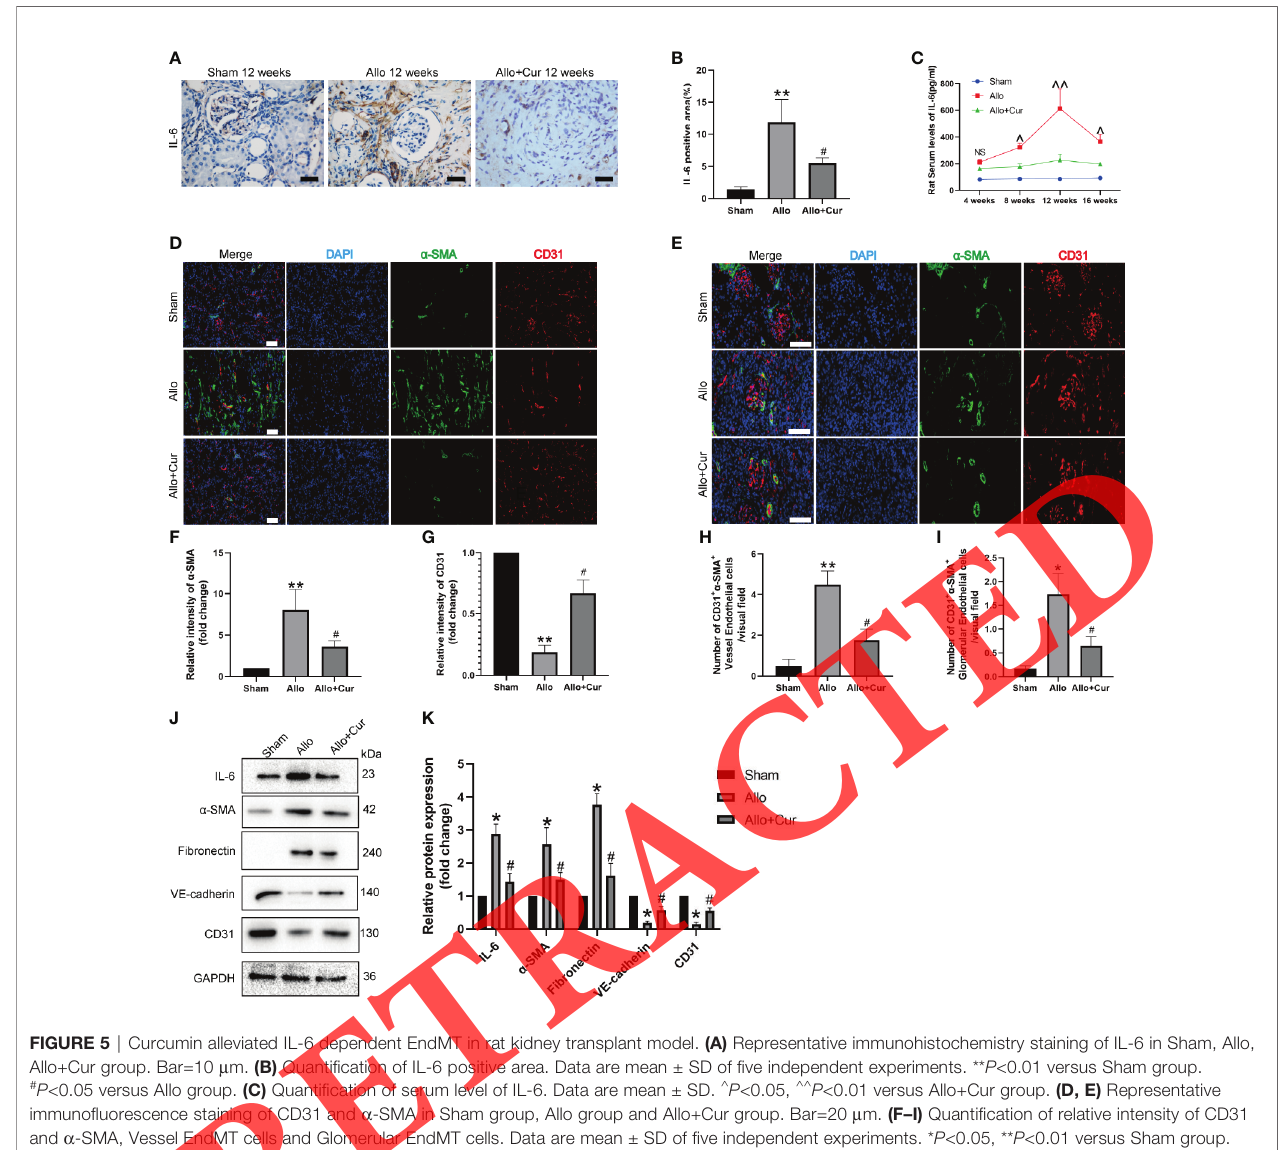
FIGURE 5 | Curcumin alleviated IL-6 dependent EndMT in rat kidney transplant model. (A) Representative immunohistochemistry staining of IL-6 in Sham, Allo, Allo+Cur group. Bar=10 m m. (B) Quanti fi cation of IL-6 positive area. Data are mean ± SD of fi ve independent experiments. ** P <0.01 versus Sham group. # P <0.05 versus Allo group. (C) Quanti fi cation of serum level of IL-6. Data are mean ± SD. ^ P <0.05, ^^ P <0.01 versus Allo+Cur group. (D, E) Representative immuno fl uorescence staining of CD31 and a -SMA in Sham group, Allo group and Allo+Cur group. Bar=20 m m. (F – I) Quanti fi cation of relative intensity of CD31 and a -SMA, Vessel EndMT cells and Glomerular EndMT cells. Data are mean ± SD of fi ve independent experiments. * P <0.05, ** P <0.01 versus Sham group. # P <0.05. (J) WB assays con fi rmed our fi ndings. Representative WB image of IL-6, CD31, VE-cadherin, FN and a -SMA. (K) Quanti fi cation of relative protein abundance of IL-6, CD31, VE-cadherin, FN and a -SMA. Data are mean ± SD of fi ve independent experiments. * P <0.05 versus Sham group. # P <0.05 versus Allo group. NS, not signi fi